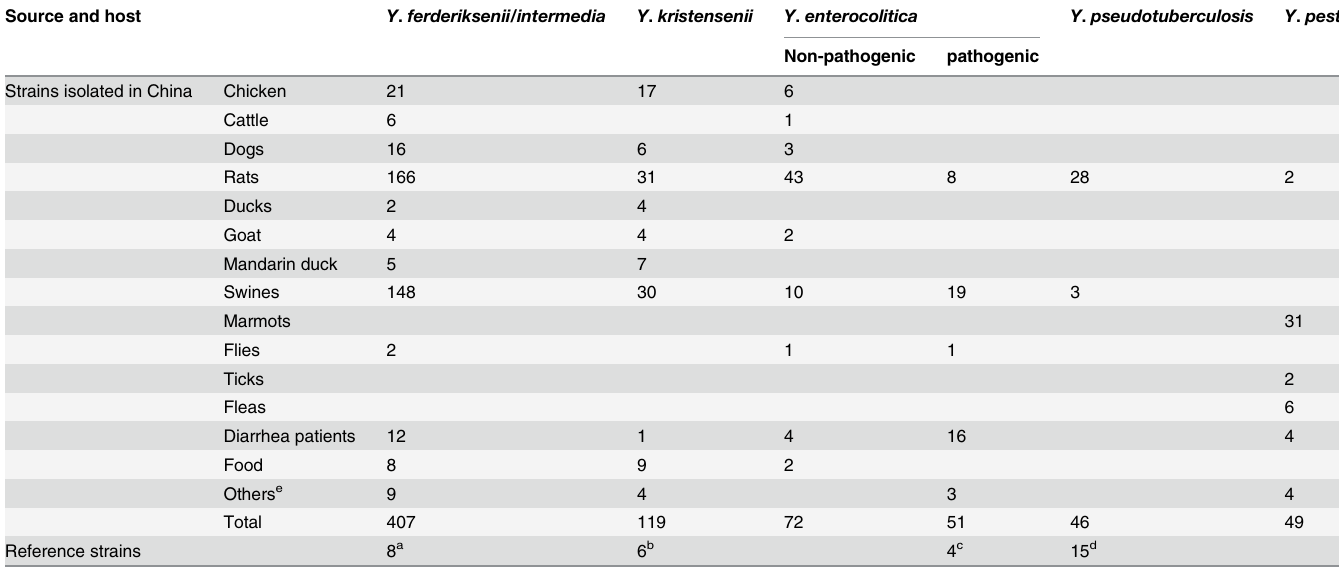
Table 1. Source and host distribution of Yersinia strains used.